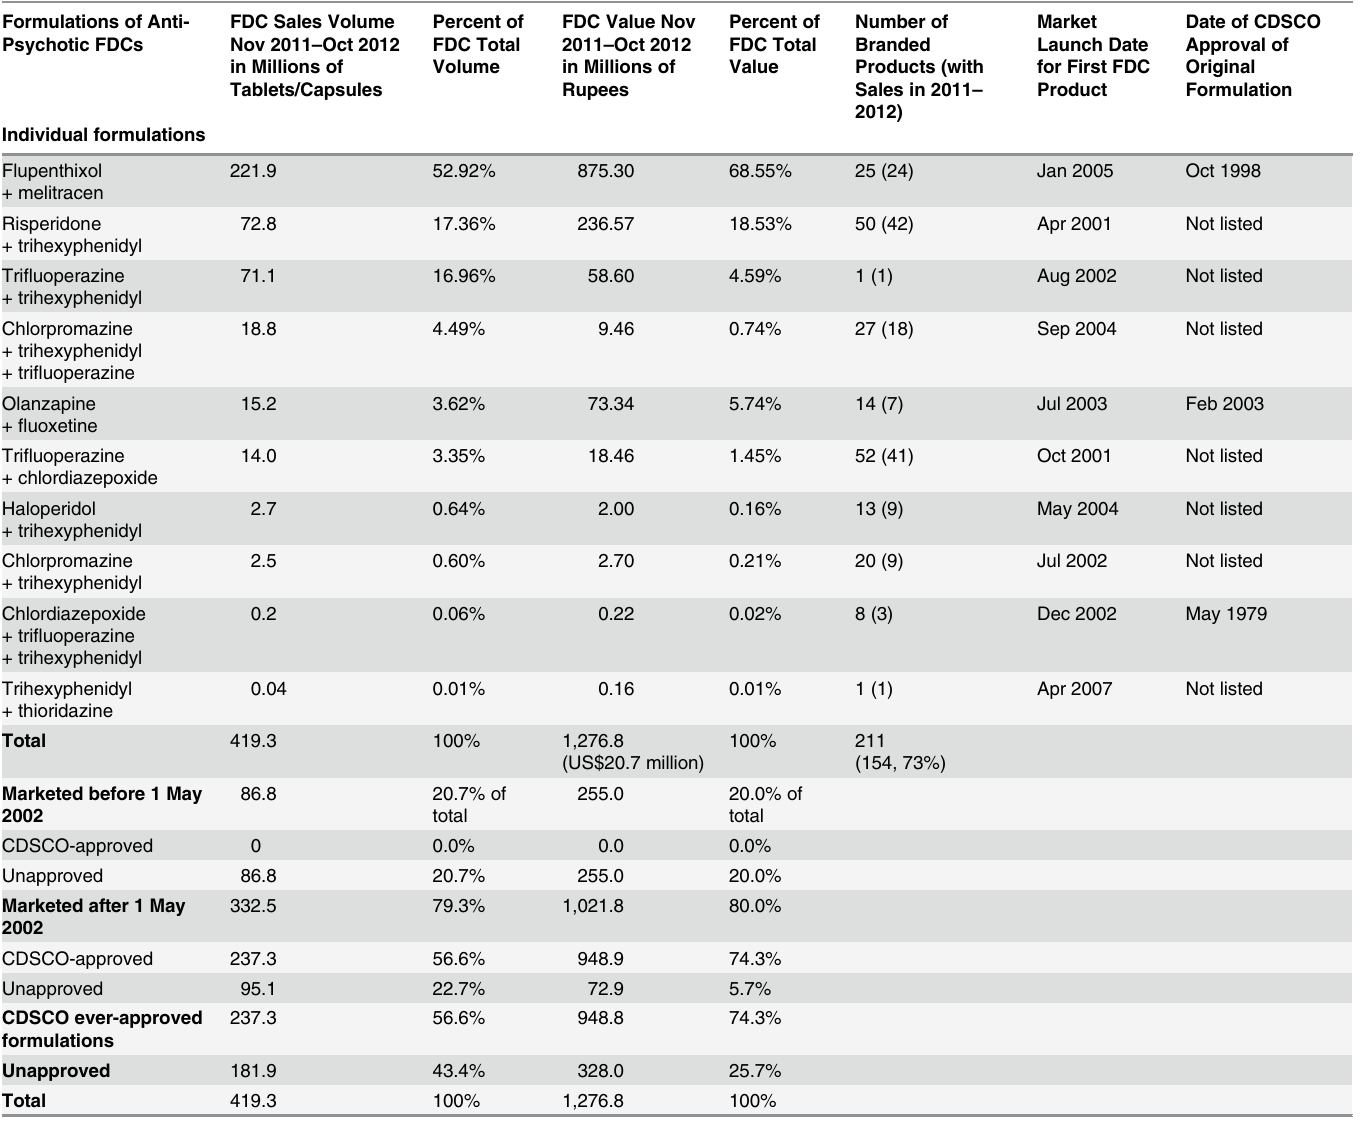
Table 4. Anti-psychotic FDC formulations marketed in